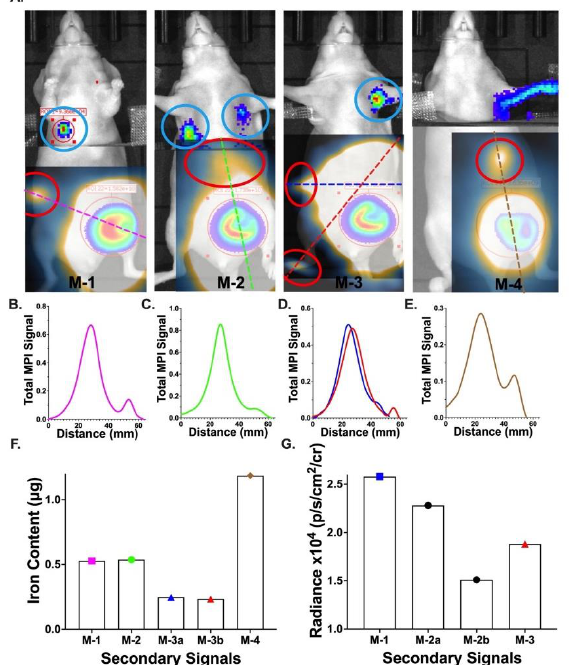
Figure 5. Secondary signals observed in MPI and Akaluc BLI in vivo. ( A ) Overlay of MPI, BLI and brightfield for each mouse (Mouse-1: Mouse-4). Secondary MPI signals are circled in red, and secondary BLI signals are circled in blue. ( B – E ) Line measurements are drawn through primary and secondary MPI signals. ( F ) Quantification of iron present in MPI secondary signals for each mouse. Mouse 3 had two secondary signals (M-3a, M-3b). Bars are color coded to the corresponding line profiles. ( G ) Quantification of secondary BLI signals from each mouse. Mouse 2 had two secondary signals (M-2a,